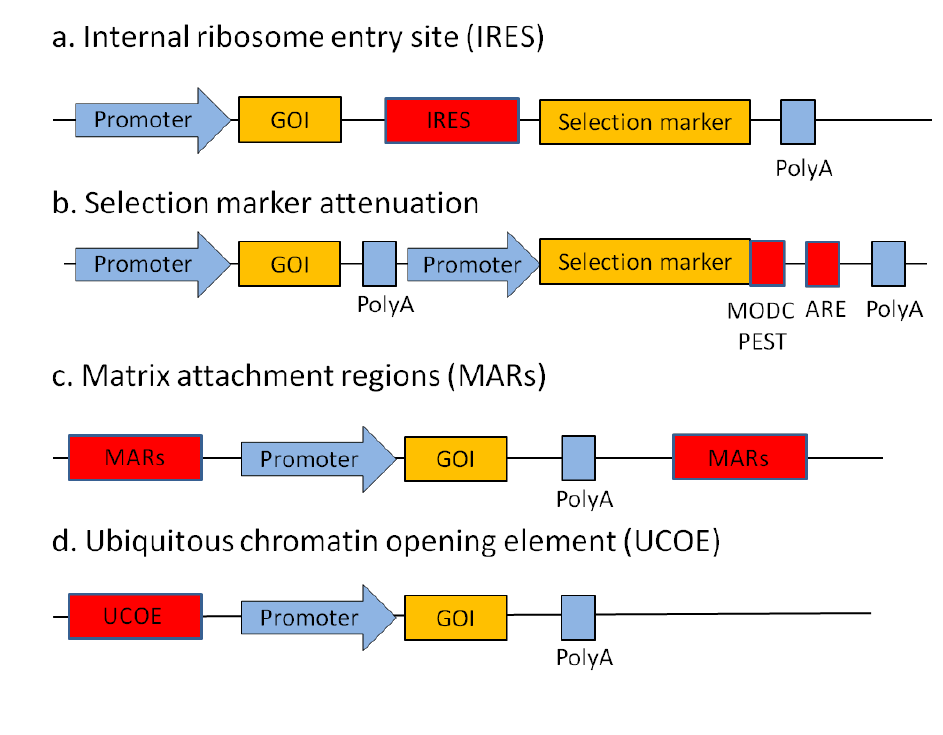
Figure 2. Illustration of expression vector engineering technologies for recombinant protein production in mammalian cells. ( a ) Selection marker attenuation increases the selection stringency which leads to increased probability of isolating cell clones with high productivity of the recombinant gene of interest (GOI). One of the strategies for selection marker attenuation involves the use of mRNA and protein destabilizing elements such as AU-rich elements (ARE) and murine ornithine decarboxylase (MODC) PEST region respectively to reduce the expression of the selection marker. ( b ) The internal ribosome entry site (IRES) is used to link expression of multiple genes. Placement of the selection marker gene downstream of the gene of interest ensures that expression of selection marker is dependent on the successful transcription of the GOI. ( c ) Matrix attachment regions (MARs) flanking the gene of interest promote gene expression by creation of chromatin loops, which maintain a transcriptionally active chromatin structure. ( d ) Ubiquitous chromatin opening elements (UCOEs) flanking the gene of interest augment gene expression by sustaining the chromatin in an “open” configuration. ( e ) Example of site- specific recombination illustrated here uses mutant λ integrase to integrate an expression cassette into the genome. The recombination event is irreversible as attP and attB target sequences are changed to attR and attL sites upon recombination. A successful recombination event will also place the promoterless selection marker gene downstream of a promoter and activate its expression to facilitate cell clone selection, while disrupting the expression of the reporter gene. Site-specific recombination to integrate the GOI into a previously determined genomic hotspot is thus promoted with the use of the recombinase and its corresponding target sequences. Identification of such genomic hotspot is dependent on the expression level of a single copy of reporter gene randomly integrated into the